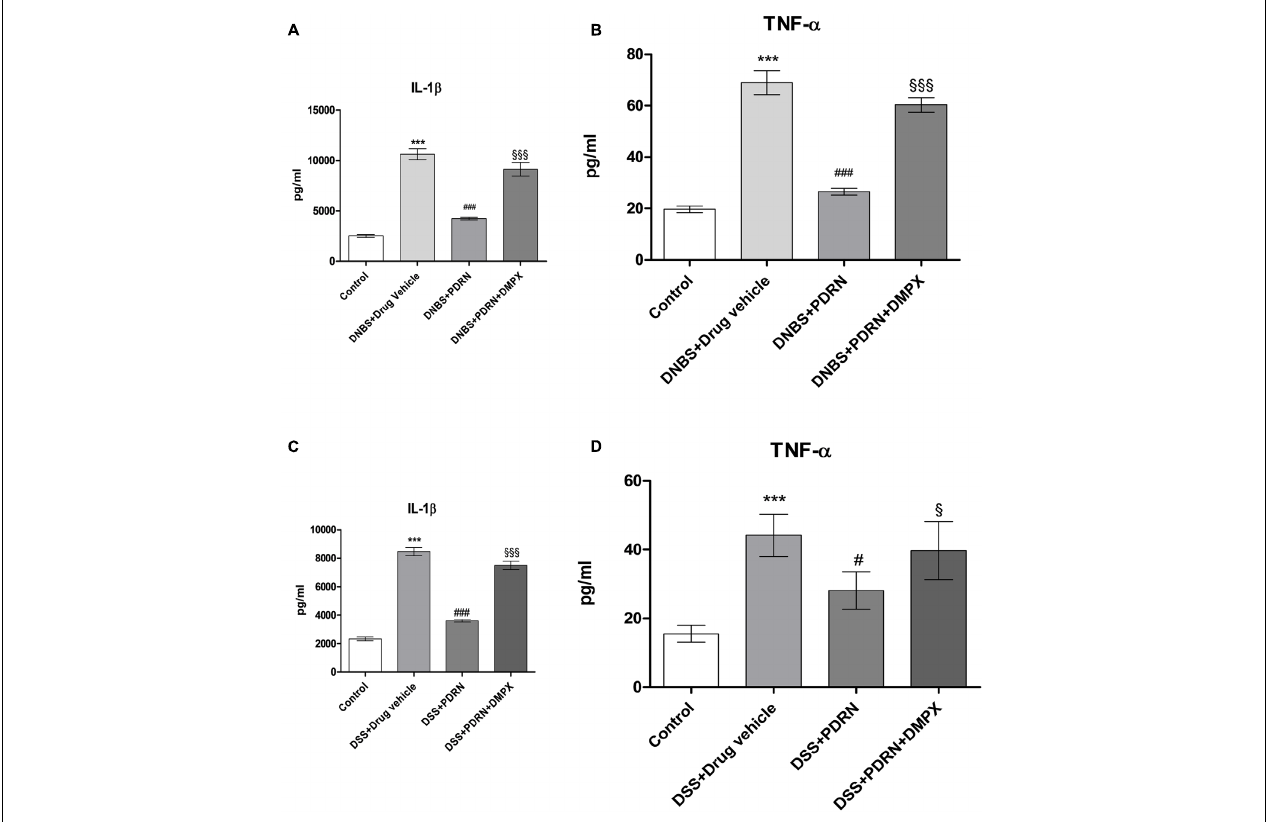
FIGURE 10 | Evaluation of inflammatory cytokines. Serum of DNBS- or DSS-challenged animals was extracted, and Interleukin 1 β (IL-1 β ) (A,C) and tumor necrosis factor-alpha (TNF- α ) (B,D) levels were determined by enzyme linked immunosorbent assay (ELISA). Values shown here are expressed as the means and SEM of seven animals per group. ∗∗∗ p < 0.0001 vs control group; # p < 0.01, ### p < 0.0001 vs DNBS/DSS + drug vehicle group; § p < 0.01, §§§ p < 0.0001 vs DNBS/DSS + PDRN